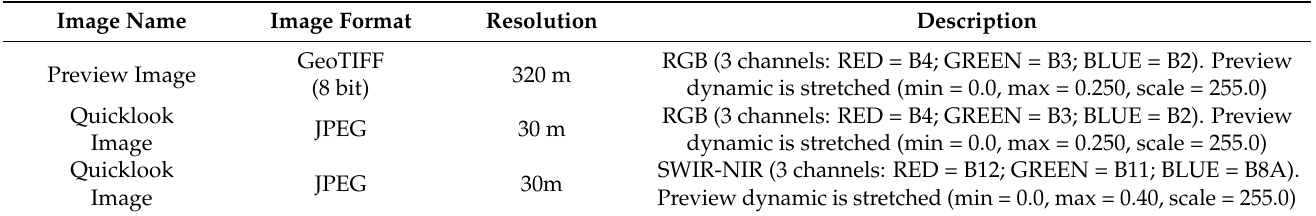
Table A2. Sen2Like preview image data.